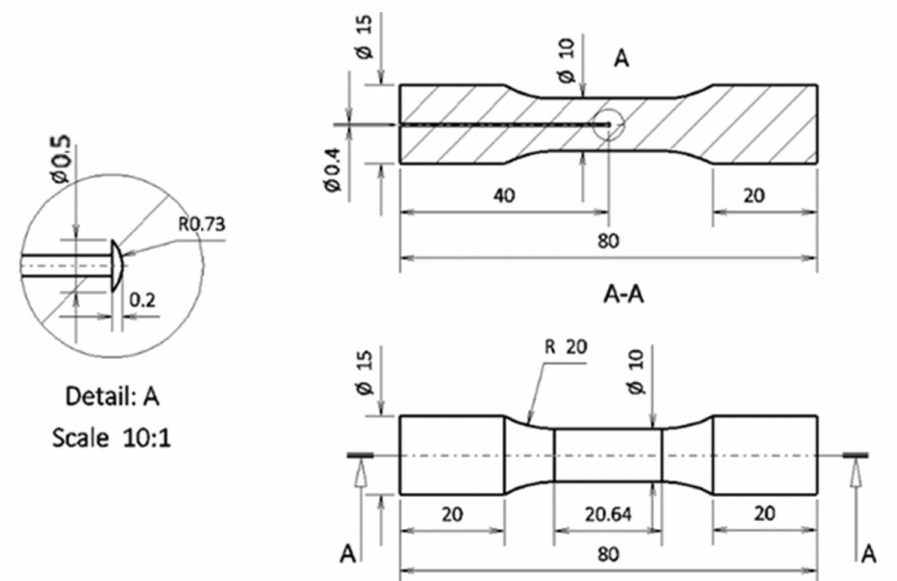
Figure 2. Cylindrical specimen with internal crack and access to external environment